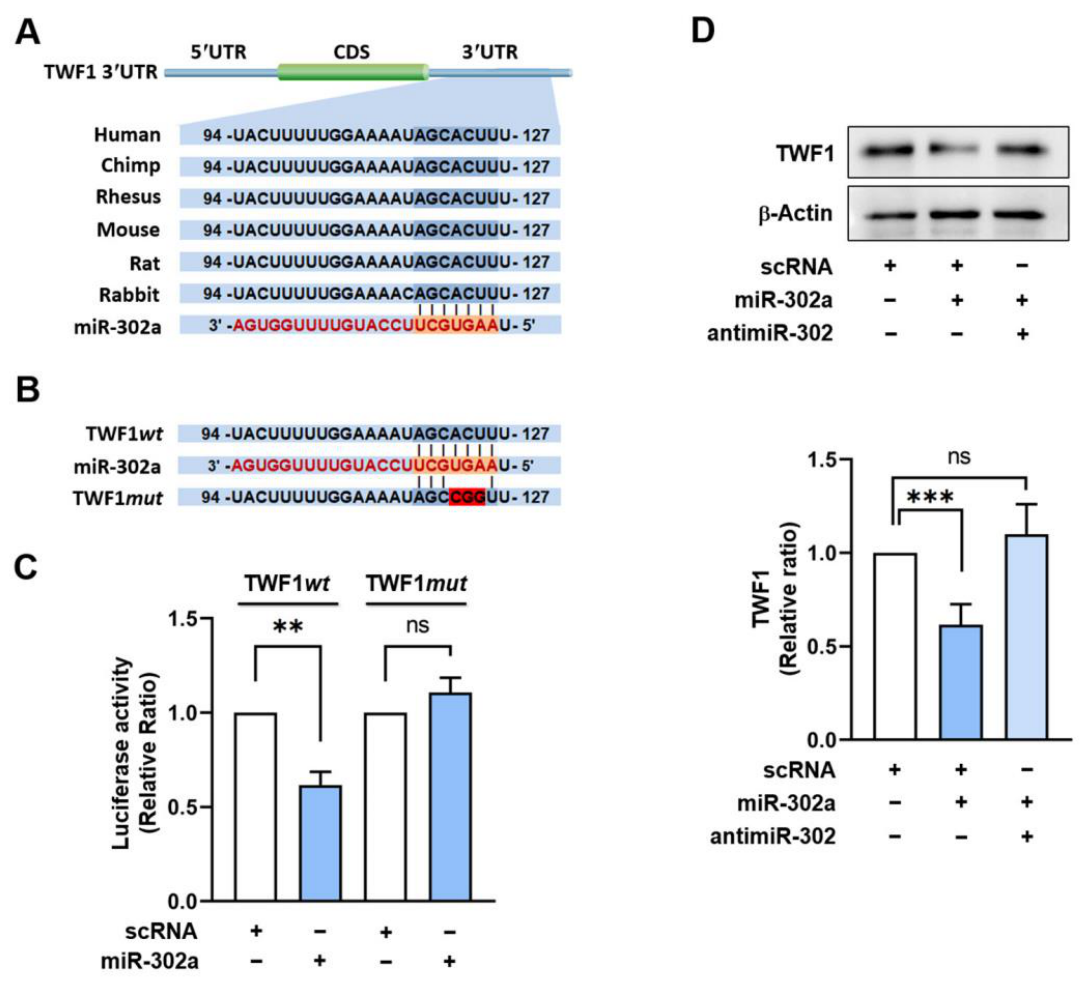
Figure 2. MiR-302a suppresses TWF1 expression by directly binding to TWF1 3′ UTR. ( A ) Schematic diagram showing the potential miR-302a binding site on the 3’UTR of TWF1 . ( B ) Sequences of the miR-302a binding sites of wild-type (TWF1 wt ) and mutant (TWF1 mut ) TWF1 3’UTR. ( C ) The dual- luciferase reporter assay was conducted 24 h after transfection in C2C12 cells. ( D ) Representative immunoblots of TWF1 in C2C12 cells 24 h after transfection with scRNA or miR-302a mimic. Immunoblot results are expressed as relative ratios versus scRNA controls and presented as means ± standard errors ( n > 3); **, p < 0.01; ***, p < 0.001 vs. scRNA. ns: no significance.